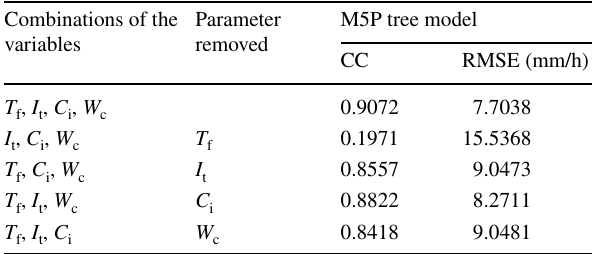
Table 7 Sensitivity analysis using M5P tree model Combinations of the